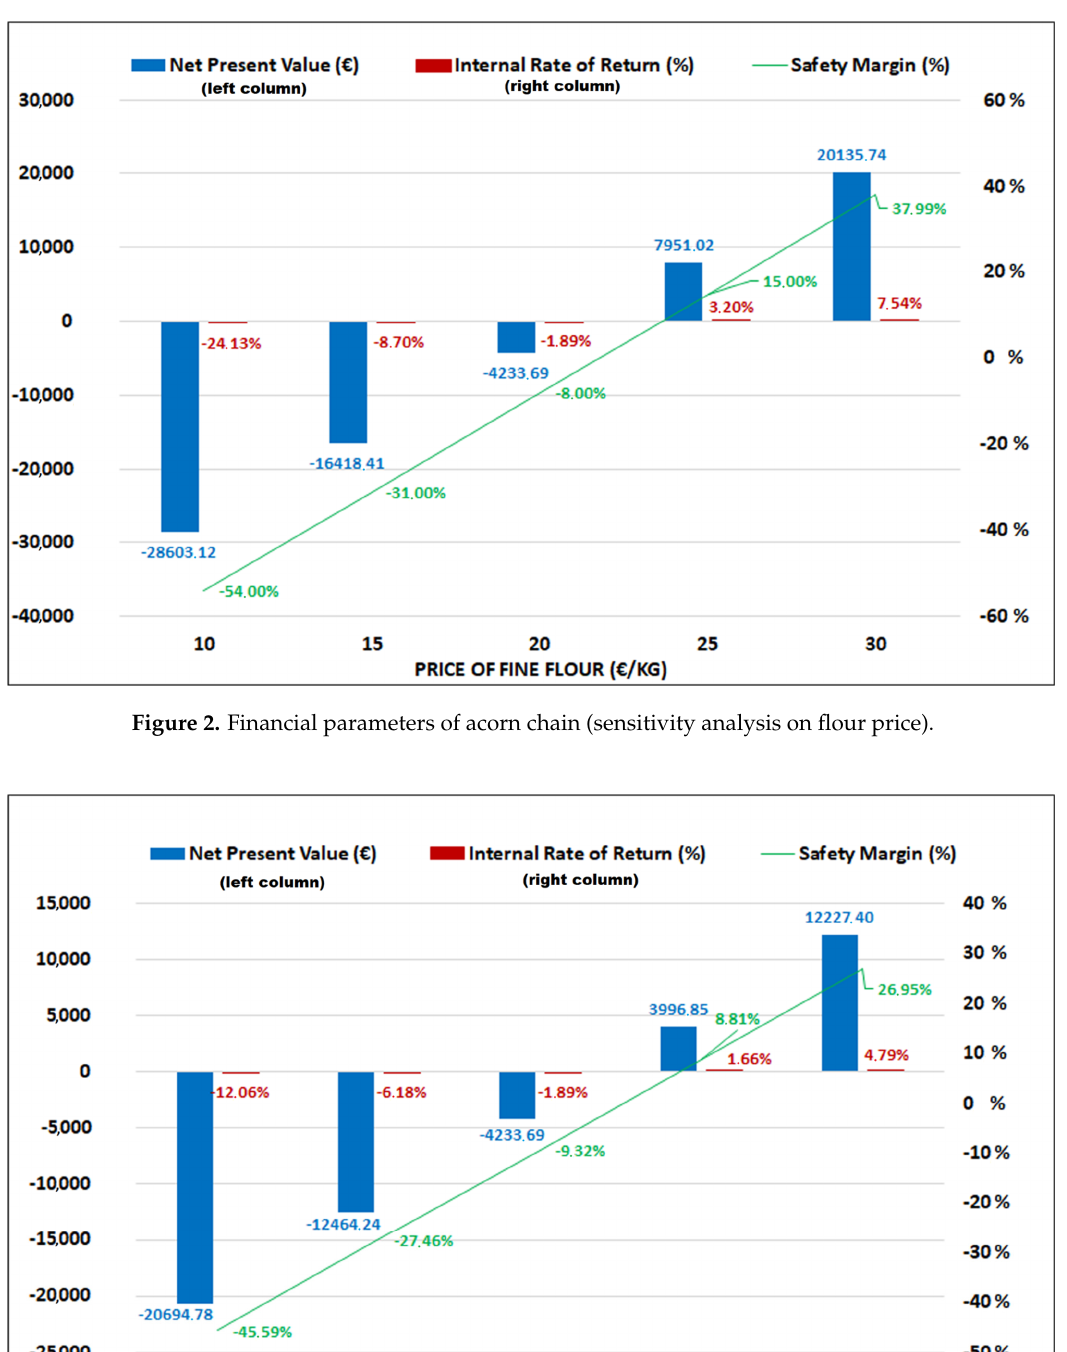
Figure 3. Financial parameters of acorn chain (sensitivity analysis on annual productivity). With an annual productivity from 15 to 35 kg/tree NPV ranges from − 20,694.78 € to 12,227.40 €. The BE on productivity is 27.57 kg/tree. Maximum hypothesised productivity (35 kg/tree) leads to an IRR of 4.79% and SM on production of 26.95%. The PBP is equal to 14 and 11 years with a productivity of 30 and 35 kg/tree,